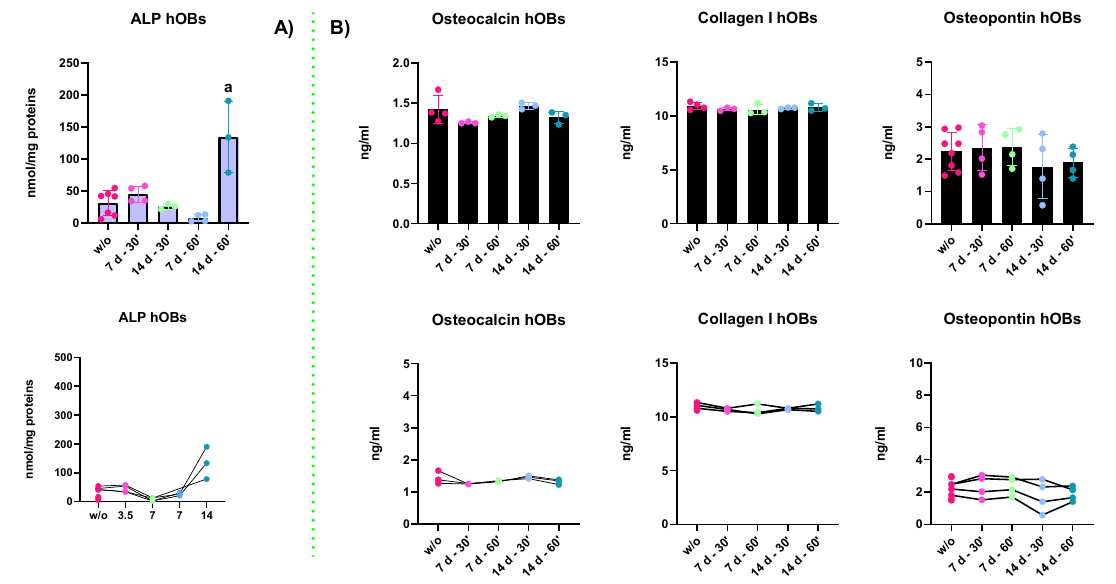
Figure 7. In ( A ) are reported the results of ALP enzymatic activity in hOBs treated with PEMFs for either 30 or 60 min. The only statistically significant difference (a) was detected between 14 d—60 ′ against all the other experimental groups. In the image below is shown the trend of ALP’s activity depending on the whole treatment’s duration, expressed in hours (h); in ( B ) are reported the results of ELISA assays of OCN, COL1A1, and OPN. As shown in the bar plots, there were no differences in the secreted structural proteins, despite the PEMF treatments. As shown in the plots below, the relative abundance of the proteins or any change in their concentration between the experimental groups was undetectable. All the data reported are expressed as the mean ± S.E.M. of two independent experiments. Before the statistical analysis was performed, the raw data were tested for normality with Kolmogorov–Smirnov normality test and further analyzed with One-Way ANOVA, followed by Tukey’s test for multiple comparisons on GraphPad Prism 8.4.2. The results were evaluated as statistically significant (a) when the p -value < 0.05.